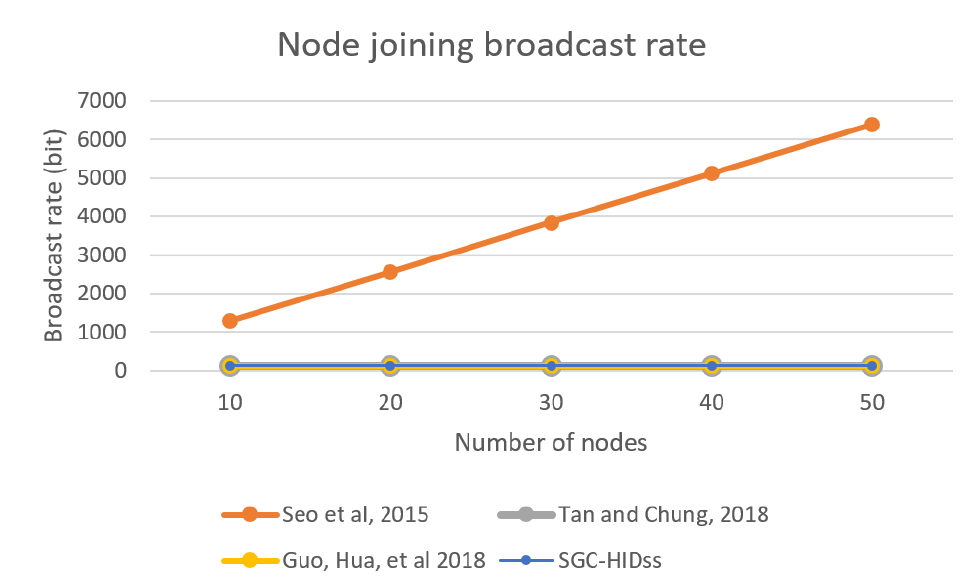
Figure 8. BS broadcast rate for each node joining the